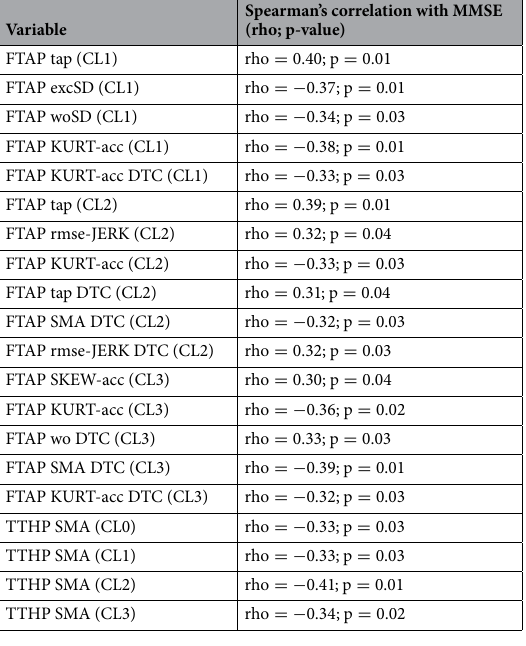
Table 2. FTAP and TTHP parameters that significantly correlates with MMSE score. The complete list of parameters extracted and evaluated is encompassed in the Supplementary